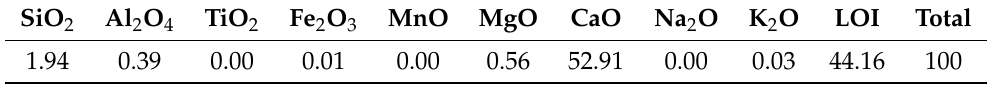
Table 1. Chemical analysis (wt%) deternined by XRF method for some domestic high-Ca limestones in Jecheon-Danyang.